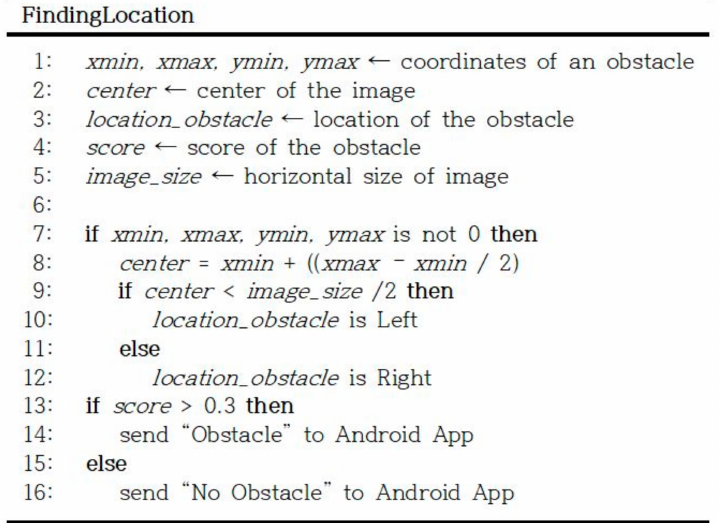
Figure 4. Algorithm for finding